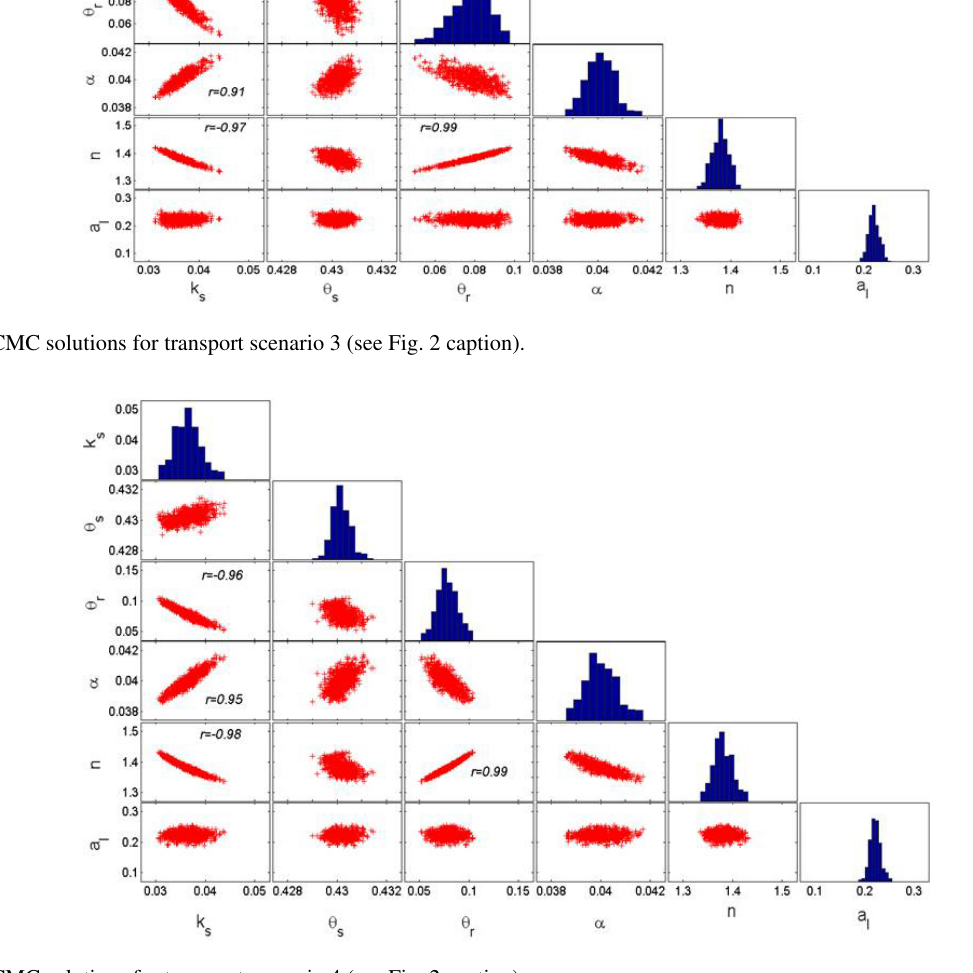
Figure 5. MCMC solutions for transport scenario 4 (see Fig. 2